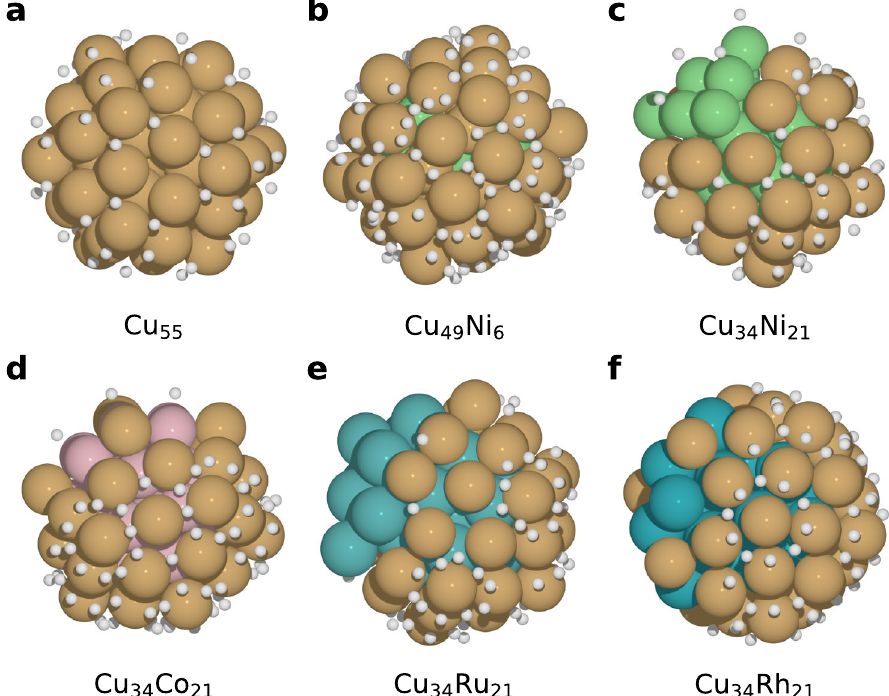
Fig. 6 Active sites for HER. The optimal adsorption sites for H on the surface of ( a ) pure Cu 55 , ( b ) Cu 49 Ni 6 , ( c ) Cu 34 Ni 21 , ( d ) Cu 34 Co 21 , ( e ) Cu 34 Ru 21 , and ( f ) Cu 34 Rh 21 clusters with | Δ G H | < 0.1